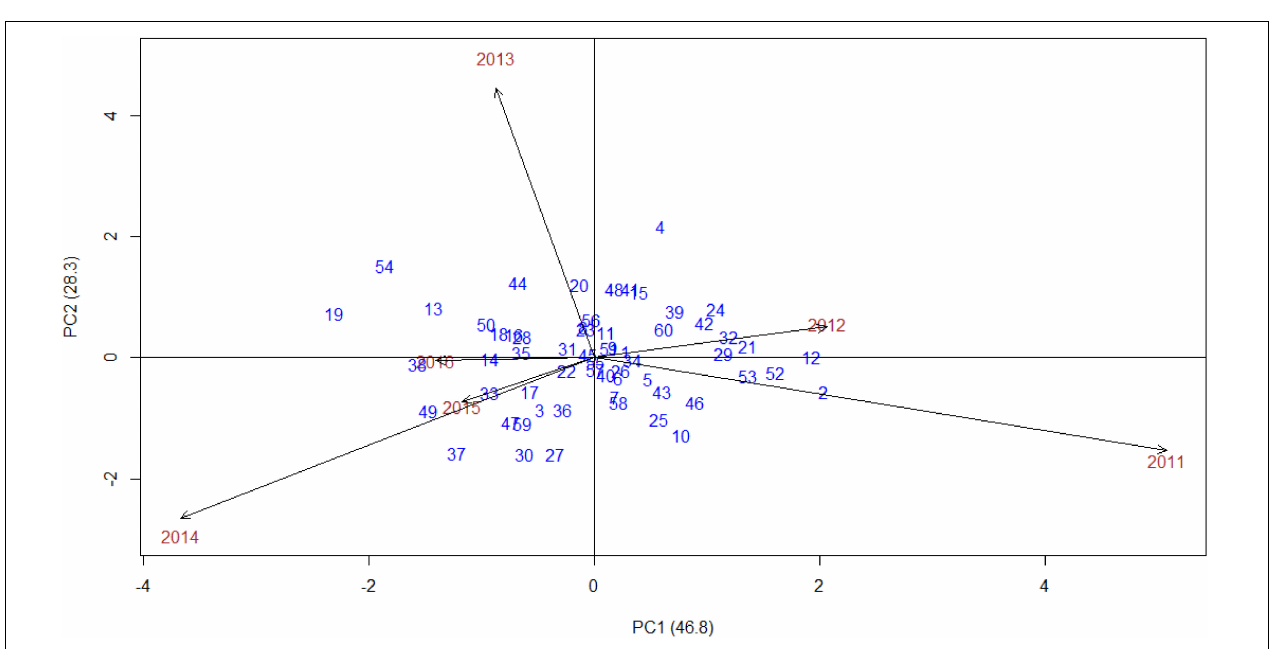
FIGURE 4 | AMMI2 biplot (PC1 vs. PC2) for grain yield (kg/ha) of 60 finger millet genotypes evaluated under six test environments during the main seasons of 2011–2016.